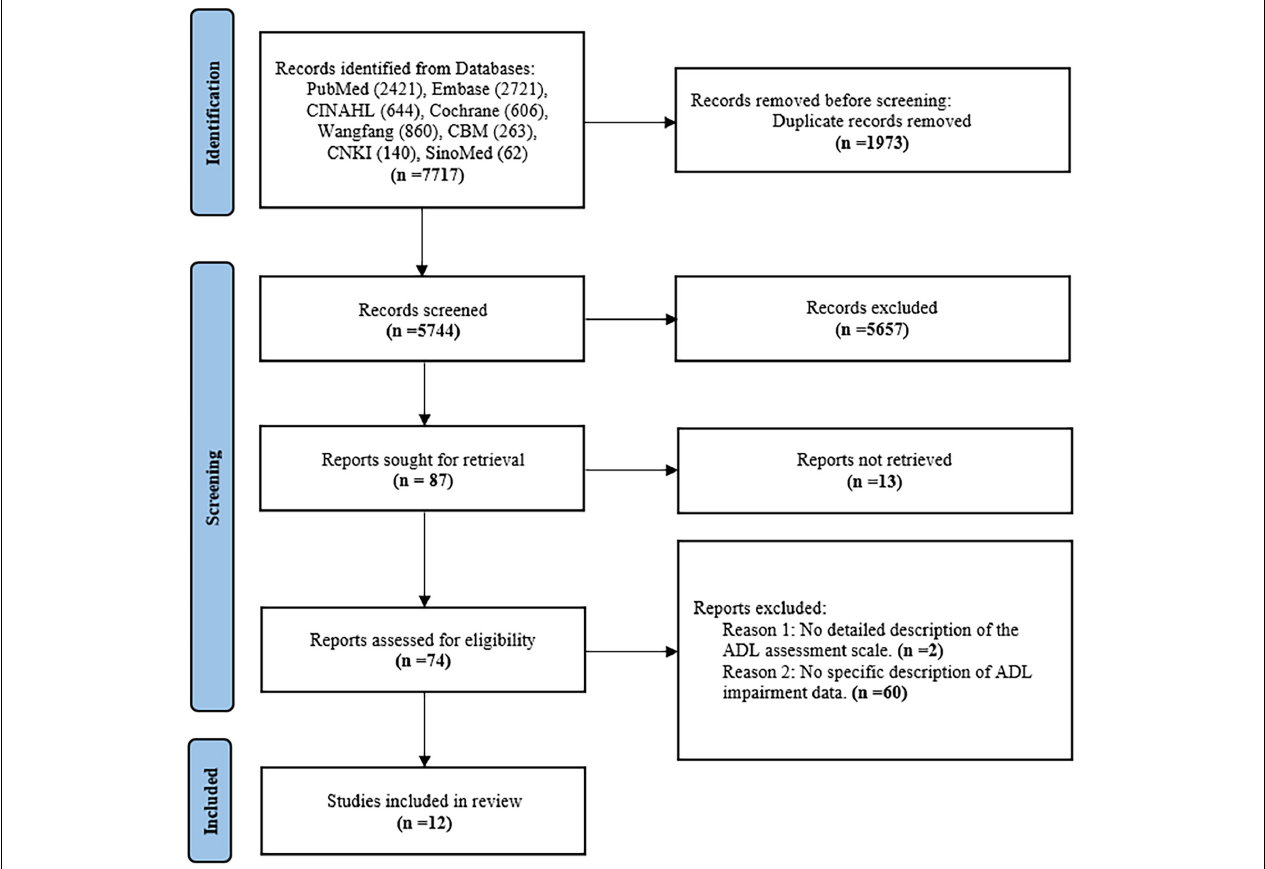
FIGURE 1 | Flow-chart illustrating the article search process.